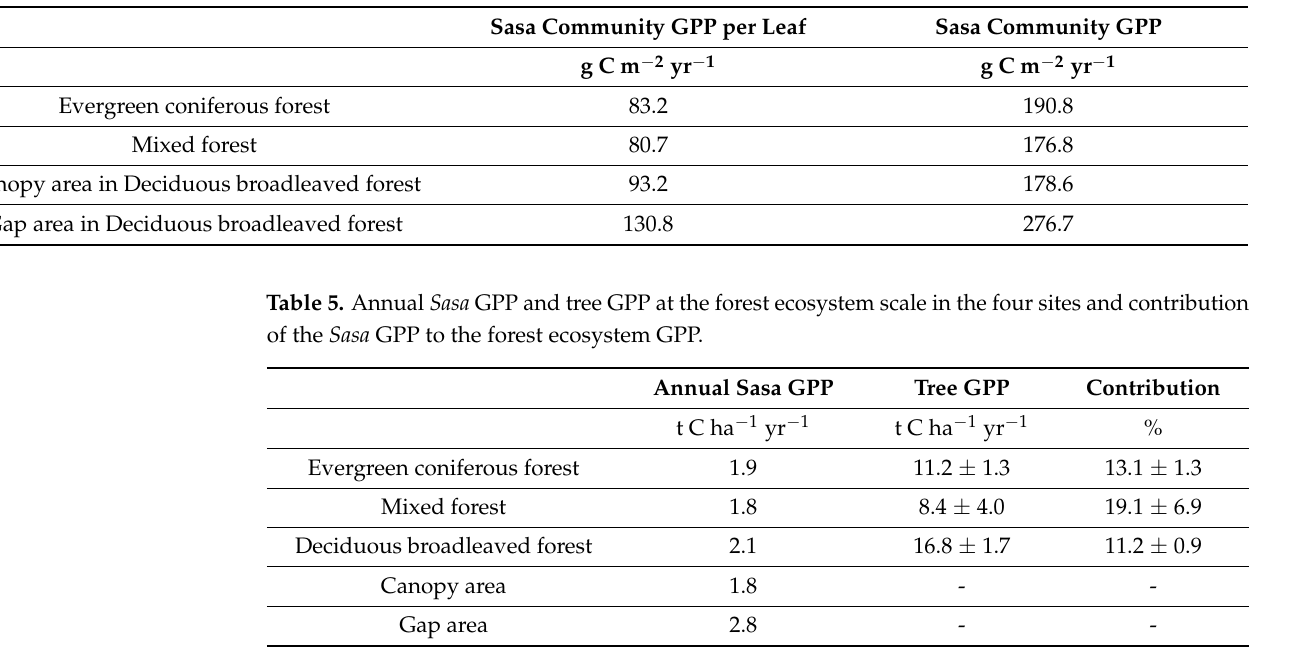
Table 4. Annual Sasa community GPP per leaf area and Sasa community GPP in the four sites.